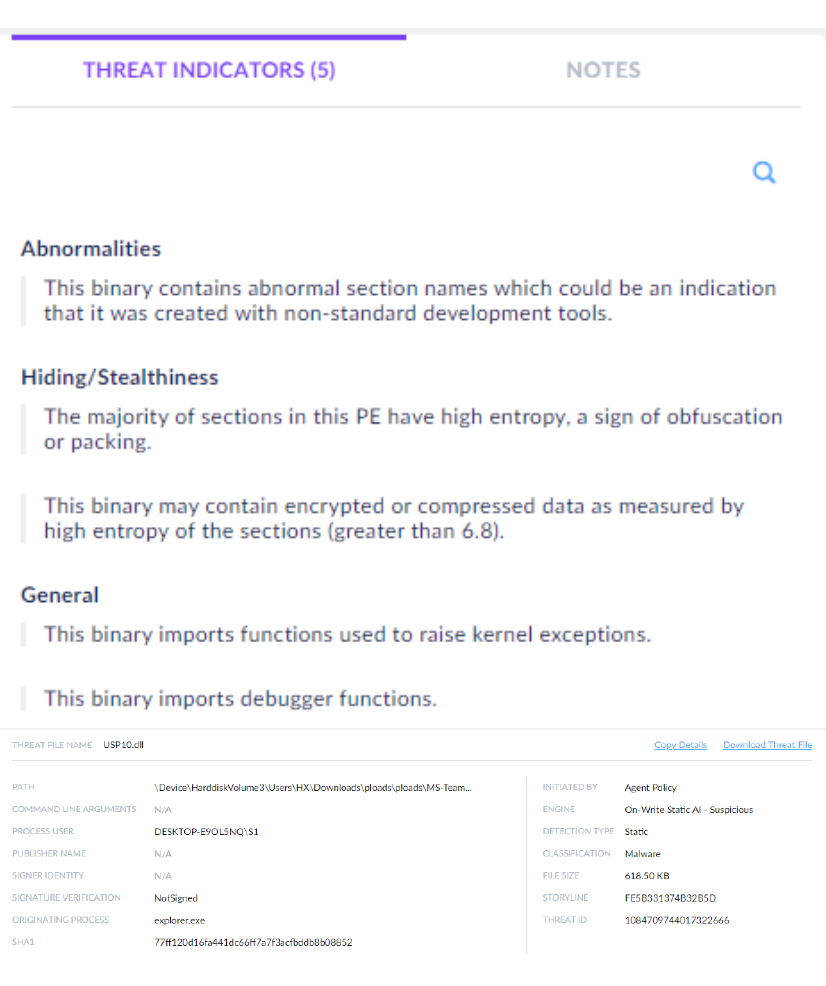
Figure 17. Sentinel One reporting the DLL